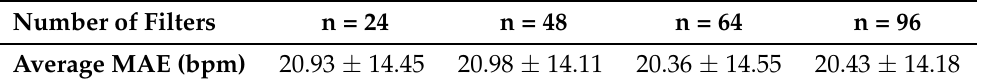
Table 2. Results for different numbers of filters with small kernel size ( k =